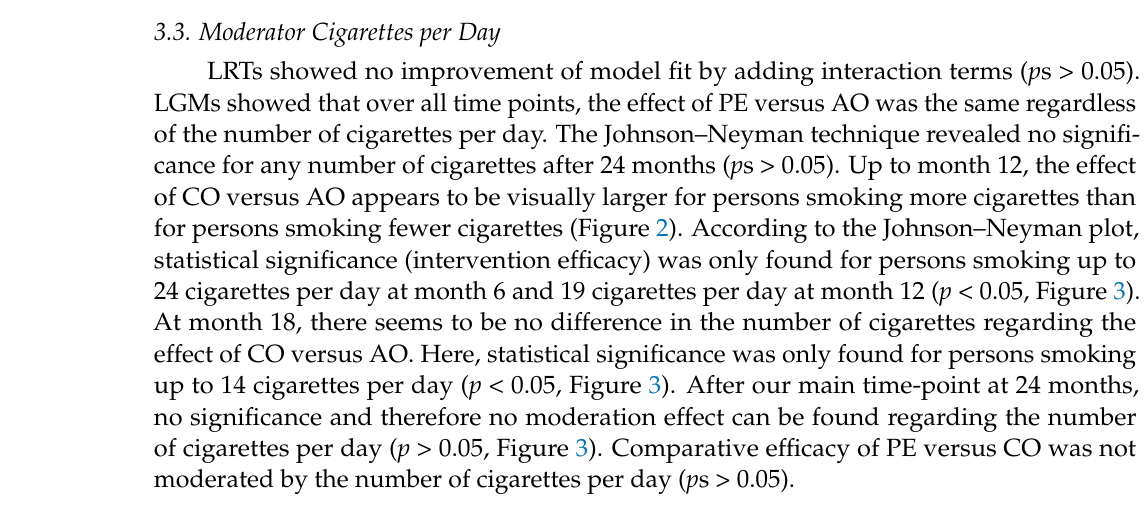
Figure 3. Plot of regions of significance for the effects of the computer-based BAI compared to assessment